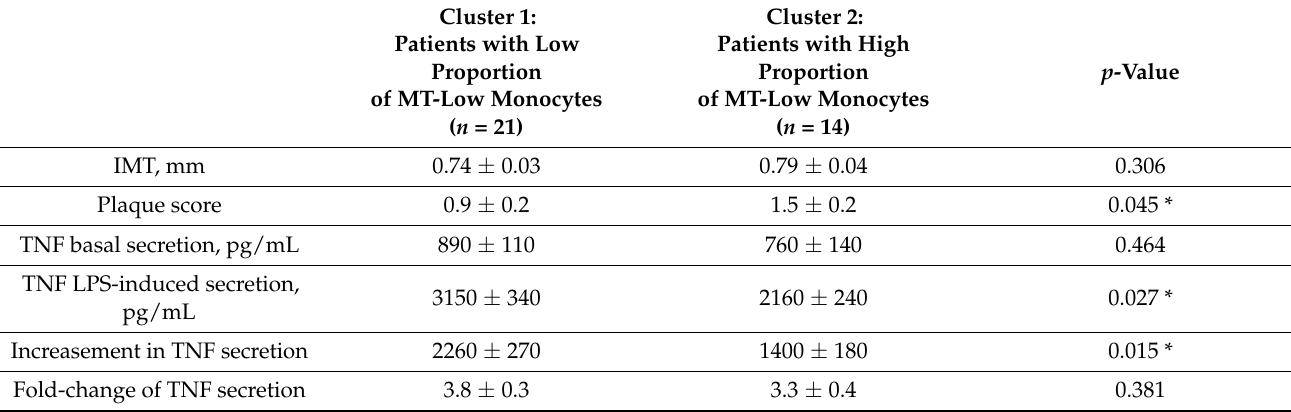
Table 3. Comparative analysis of study subjects with a low or high proportion of MitoTracker-low